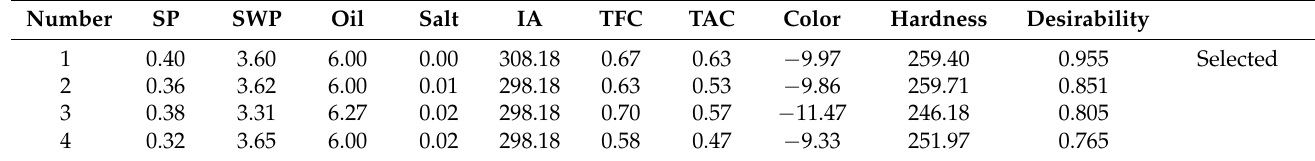
Table 4. The optimal sample of D-optimal